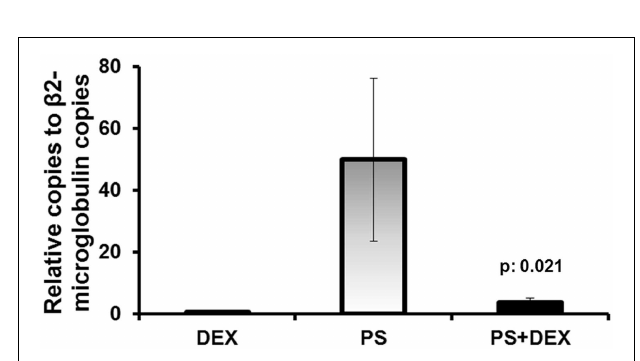
FIGURE 4 | Dexamethasone is not a modulator ofTREM-1 expression in TNF − / − mice .TNF − / − male mice were challenged by a multidrug-resistant isolate of P. aeruginosa . Mice were pre-treated 1h before challenge with either saline (CON) or dexamethasone (DEX). In (A) , survival of 10 control mice (solid line) and 10 DEX mice (dashed line) is shown. In (B,C) , expression